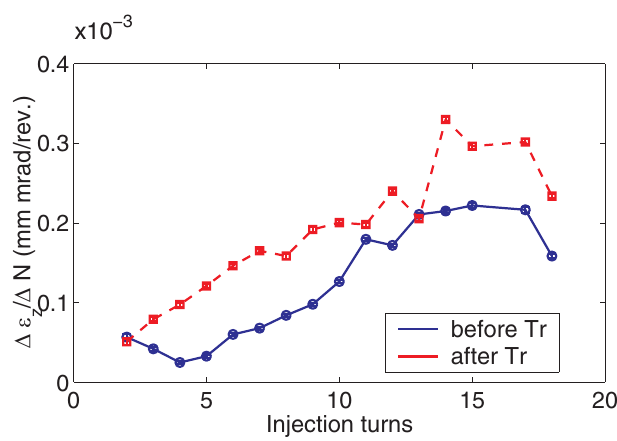
FIG. 9. (Color) The vertical emittance growth rate before (blue) and after (red) transition for all data